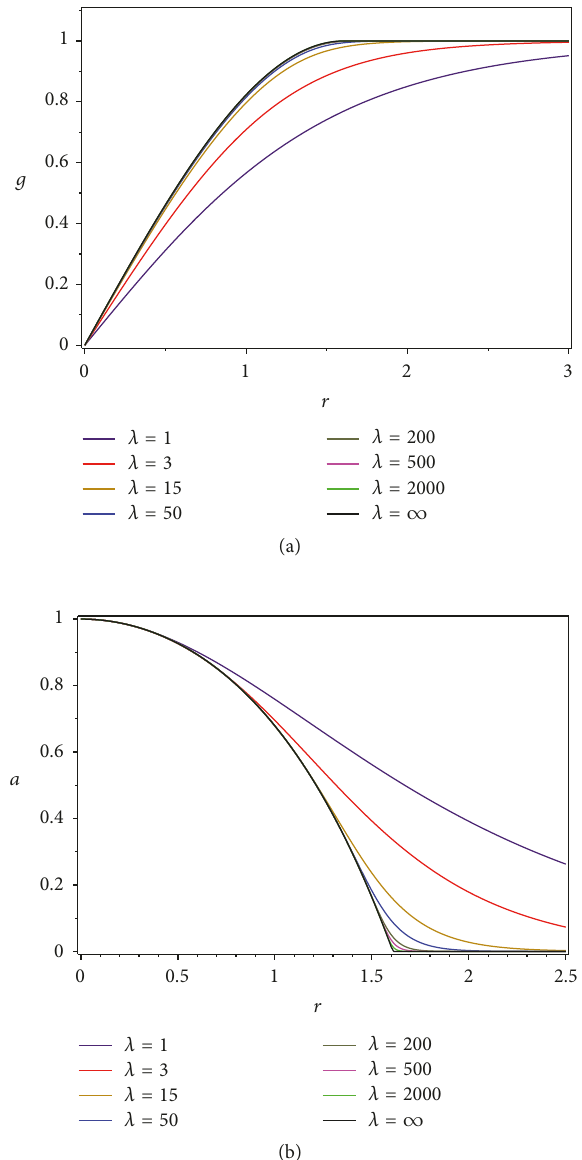
Figure 7: The profiles 𝑔(𝑟) (a) and 𝑎(𝑟) (b) come from generalized Maxwell-Chern-Simons-Higgs model (93) with 𝐺(𝑔) = 1 and 𝜔(𝑔) = 𝜆𝑔 2𝜆−2 . Observe that 𝜆 = 1 (indigo lines) represents the usual MCSH model and the true compacton solution is given by 𝜆 = ∞ (black lines).